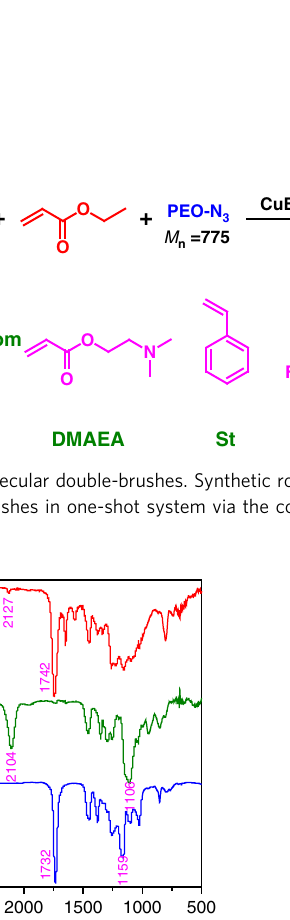
Fig. 3 Monitoring of CuAAC click reaction. GPC traces of ATRP/CuAAC system for PA- g -PEA/PEO 5 asymmetric molecular double-brush before ( red ) and after ( blue ) the reaction, feeding ratio: [-N 3 ]: [-C ≡ CH] = 4:1 and [EA]:[-Br] = 150:1, internal standard: PS ( M n = 3790 g mol − 1